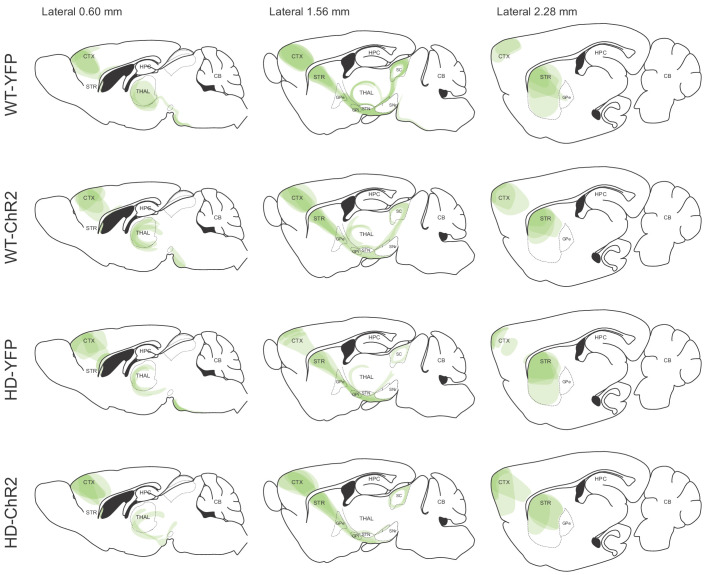
Validation of the AAV expression from the M2 cortex and its projections by YFP fluorescence.Overlay of the YFP expression from different mice was drawn over three representative sagittal sections: mediolateral coordinates 0.6, 1.56, and 2.28 mm obtained from the brain atlas (Franklin and Paxinos, 1997). For each of the animals studied, brain slices were analyzed, and the visualized virus-infected-pathways were plotted manually in the corresponding sagittal section. Each of the represented brain images contains different layers from four mice, each animal represented with a color opacity of 20%.